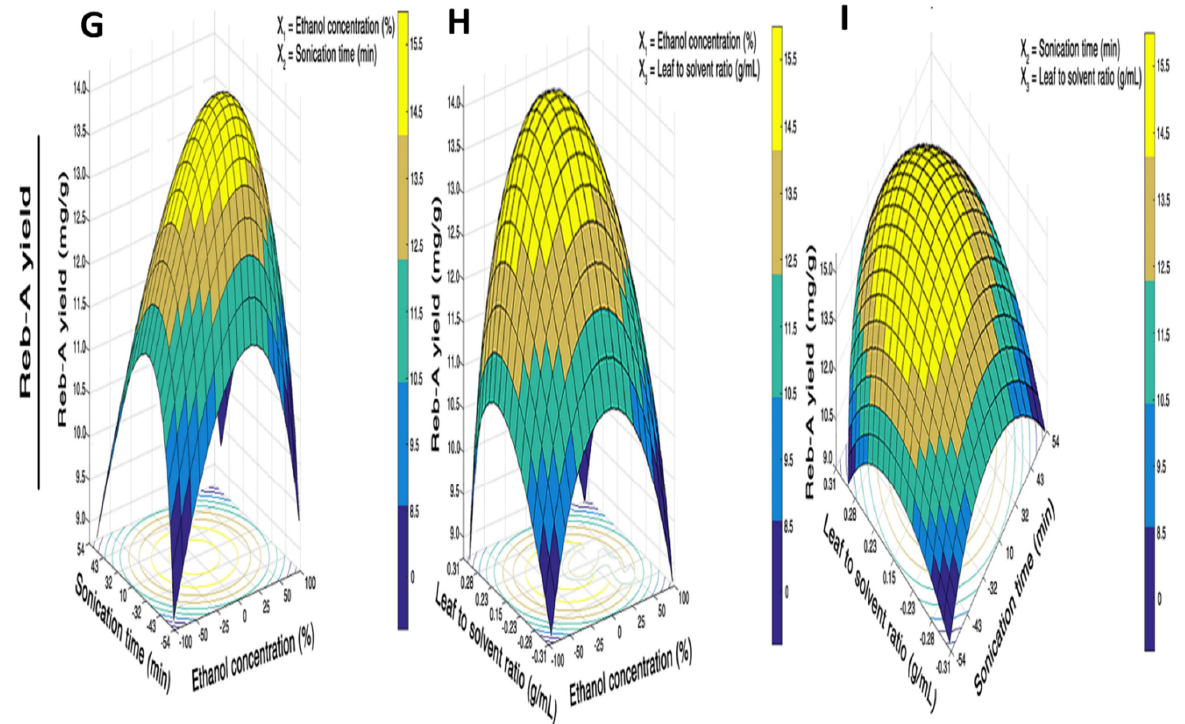
Figure 3. 3D response surface curve and corresponding contour plots of TEY showing the interac- tion effect of the concentration of ethanol and sonication time at fixed level of leaf–solvent ratio (0.23 g·mL − 1 ). ( A ) Concentration of ethanol and leaf–solvent ratio at a fixed level of sonication time (32 min) ( B ) and sonication time and leaf–solvent ratio at a fixed level of concentration of ethanol (50%). ( C ) ST yield showing the interaction effect of concentration of ethanol and sonication time at fixed level of leaf–solvent ratio (0.23 g·mL − 1 ). ( D ) Concentration of ethanol and leaf–solvent ratio at fixed level of sonication time (32 min) ( E ) and sonication time and leaf–solvent ratio at fixed level of con- centration of ethanol (50%) ( F ); Reb − A yield showing the interaction effect of concentration of etha- nol and sonication time at fixed level of leaf–solvent ratio (0.23 g·mL − 1 ). ( G ) Concentration of ethanol and leaf–solvent ratio at fixed level of sonication time (32 min) ( H ) and sonication time and leaf– solvent ratio at fixed level of concentration of ethanol (50%) ( I ).